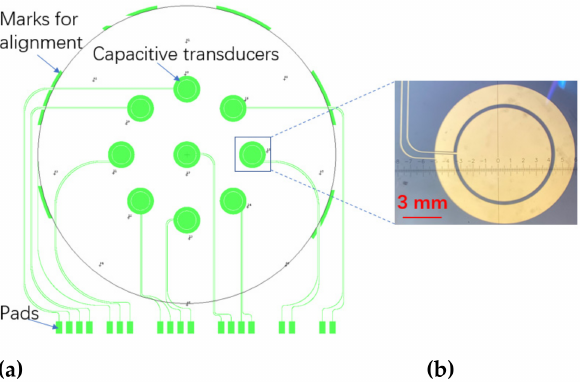
Figure 4. Designofthesurfaceprofilemeasurementsystem. ( a )Thearrangementofthemulti-gridcapacitive transducers on a 5-inchsquare glass wafer; ( b ) the microscope image of a single capacitive